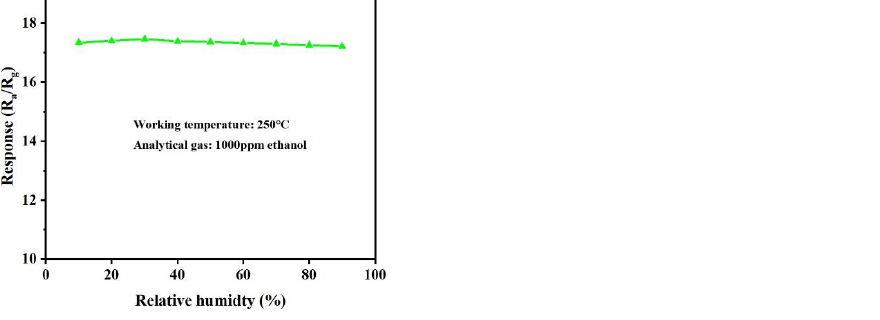
Figure 9. Gas response of Sn/SnO 2 sample to 1000 ppm of different VOCs at 250 °C.